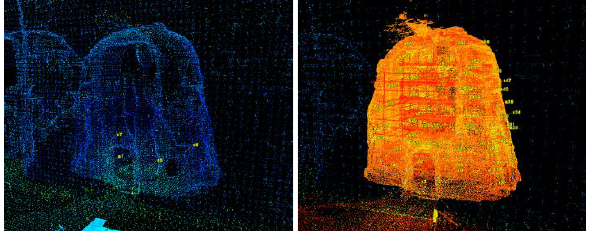
Figure 3. Point cloud data before and after